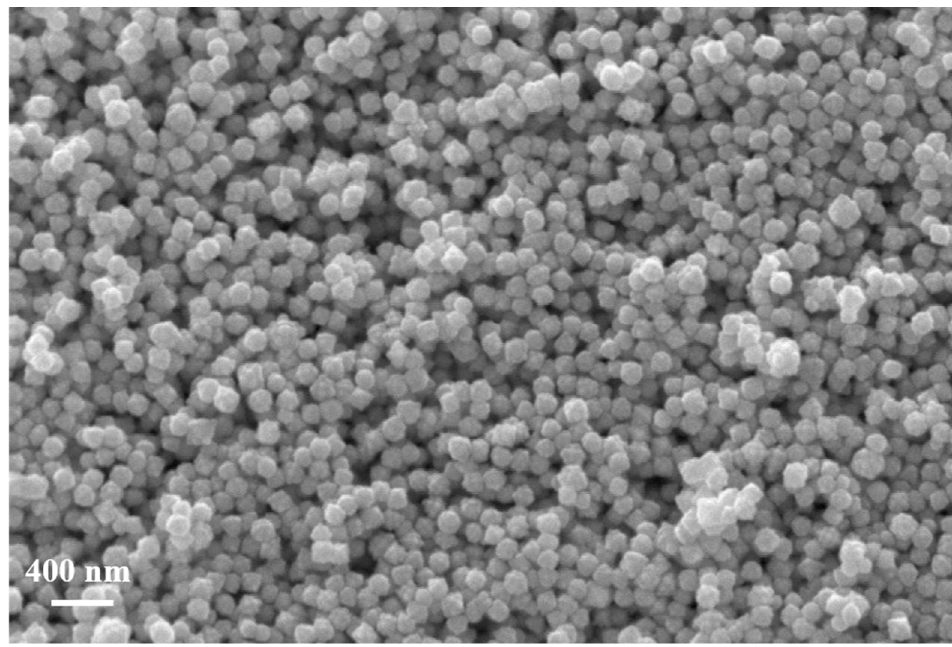
Figure 3. Initial tungsten nanoparticles. after synthesis using MSGA method.